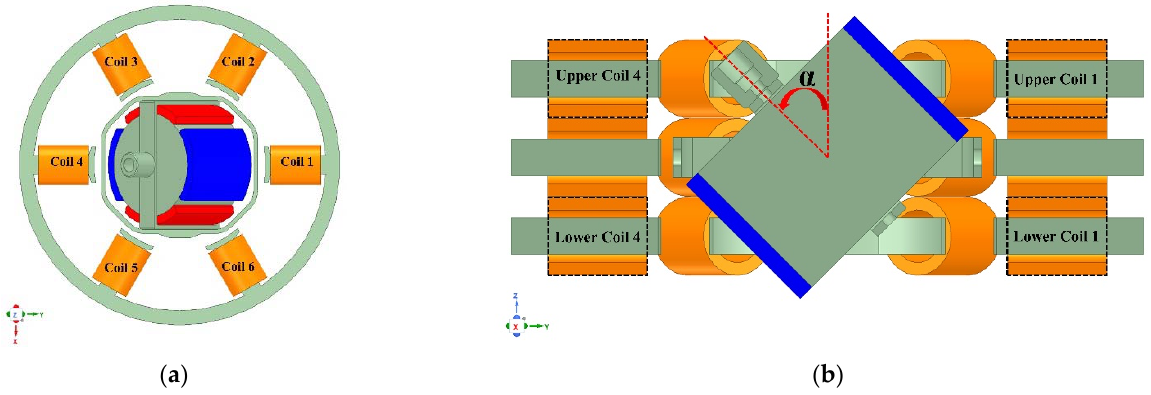
Figure 3. The working principle for the motor rotating around the X ‐ axis: ( a ) top view of the rotor that is at α = 45°; ( b ) YZ cross ‐ section view of the rotor that is at α = 45°.